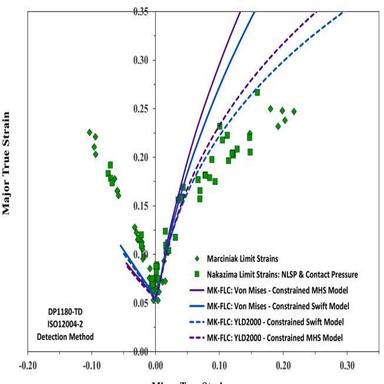
Comparison of MK-predicted FLCs in the transverse direction of DP1180 using different yield functions and the constrained MHS and Swift hardening models.